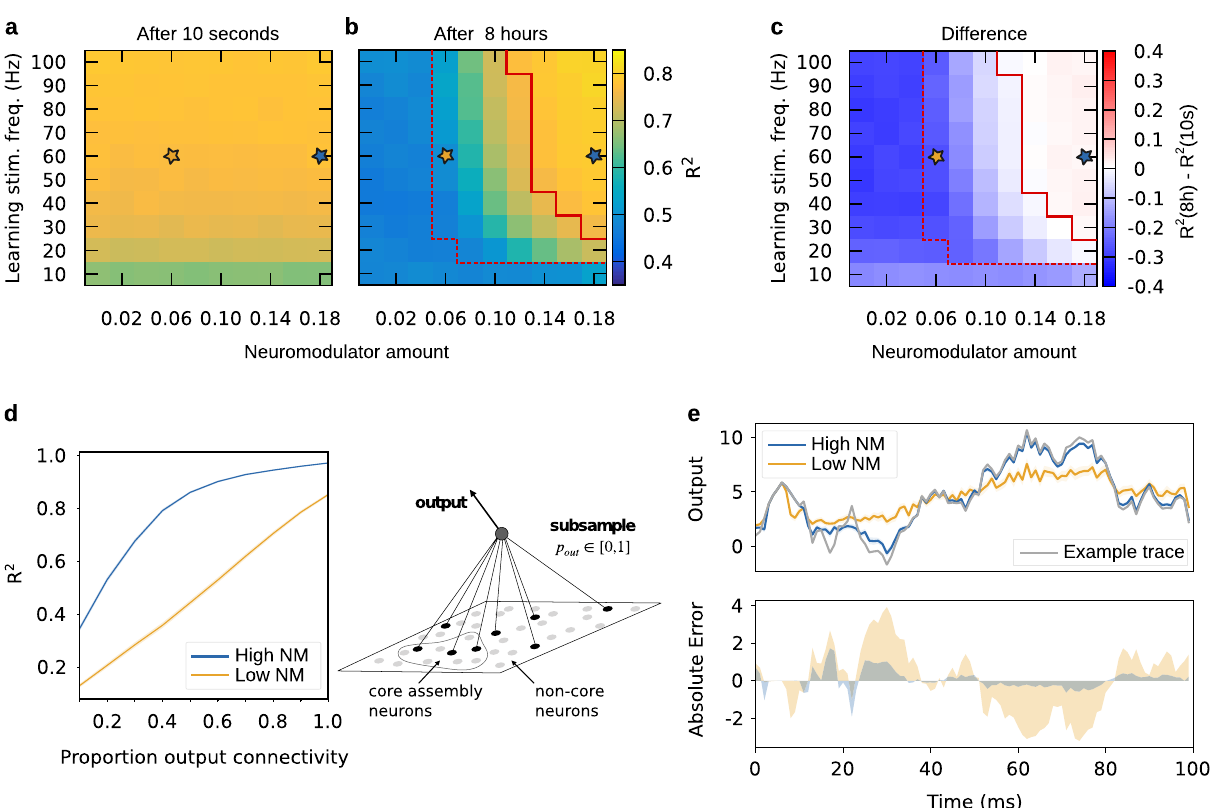
Figure 7. High level of neuromodulation during consolidation supports readout of temporal sequences. The 2 goodness of fit ( R ) of the regularized linear regression model is shown for recall ( a ) 10 s and ( b ) 8 h after learning. Yellow star represents low neuromodulator condition, blue star high neuromodulator. ( c ) The impact of neuromodulator-dependent STC on the shared temporal information during learning and recall is measured as the difference between the 8 h and 10 s results. ( d ) The goodness of fit is shown for high (blue) and low (yellow) across different percent output connectivities. A depiction of the subsampling process is shown on the right. Here we sample from all 1600 excitatory neurons, see Supplementary Figs. S5 and S6 for sampling from only core and only non-core neurons. ( e ) The predicted trajectories at 8 h recall in the low (yellow) and high (blue) neuromodulator conditions are shown for one example target function (gray). The bottom panel shows the absolute error (with sign). Data in ( a – c ) were averaged over 5000 instances: 50 networks with 10 target functions, across 10 values of proportion output connectivity. In ( d ), 500 instances were averaged for each proportion output connectivity: 50 networks, 10 target functions. In ( e ), the average of 50 networks is shown for an example target function and p out = 0.5 . Error bands in ( d , e ) show the 95% confidence